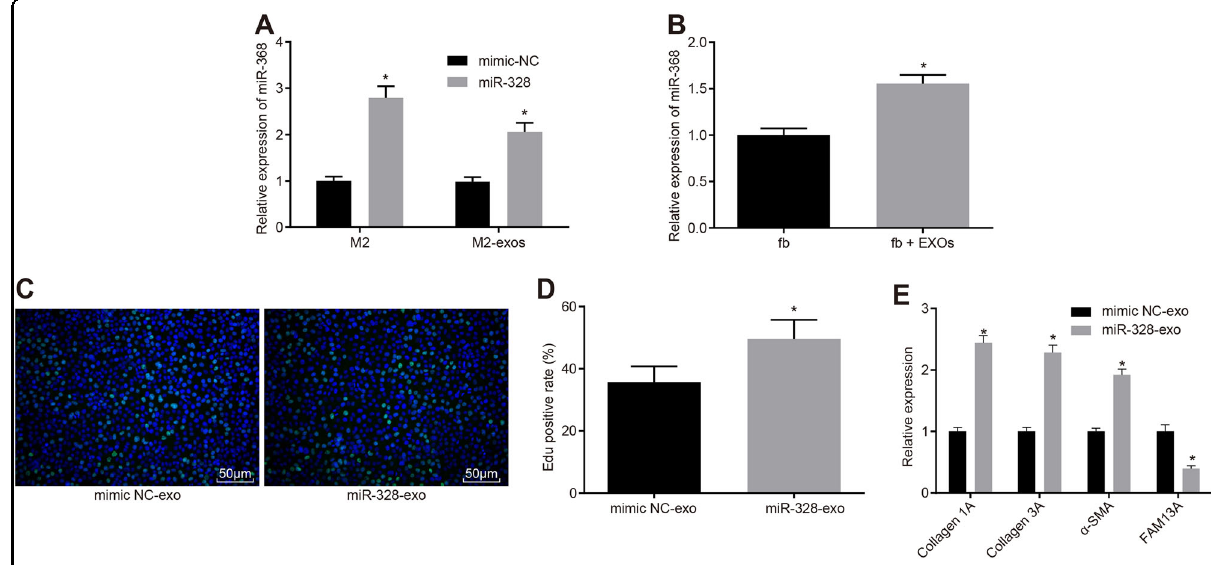
Fig. 6 M2 macrophage-exosomes carry miR-328 into pulmonary interstitial fi broblasts . a miR-328 expression in macrophages and exosomes examined by RT-qPCR . b miR-328 expression in pulmonary interstitial fi broblasts after a coculture with exosomes, as measured by RT-qPCR , * p < 0.05 vs . pulmonary interstitial fi broblasts cocultured with exosomes. c EdU labeling to examine the proliferation of pulmonary interstitial fi broblasts in the mimic NC-exo and miR-328-exo groups (200 × ). d Quanti fi cation of the results in b , *, p < 0.05 vs . the mimic NC-exo group; e Expression of Collagen 1A, Collagen 3A, α -SMA and FAM13A in the mimic NC-exo and miR-328-exo groups measured by RT-qPCR , * p < 0.05 vs . the mimic NC-exo